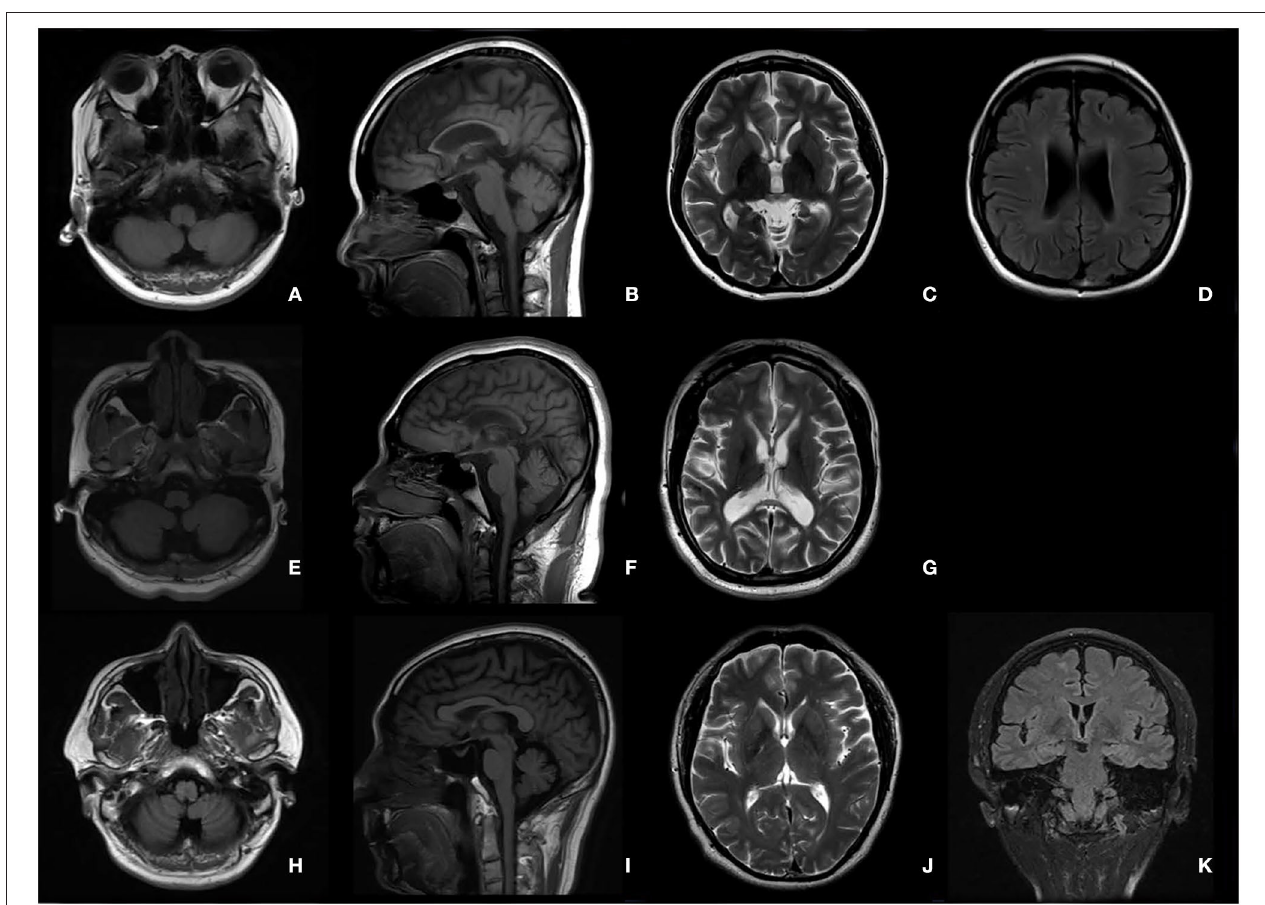
FIGURE 4 | Brain MRI in patients with SPG11 (A–D) , SPG15 (E–G) , and SPG 5A (H–K) . A thin corpus callosum (B,F) , “ear of the lynx” sign (C,G) , and ventricular dilation (D,G) were found in a female patient with SPG11 aged 25 years and a male patient with SPG15 aged 24 years. Periventricular white matter hyperintensities (D) are shown in the female patient with SPG11. No cerebellar atrophy was found in the patient with SPG11 (A) or in the patient with SPG15 (E) . Cerebellar atrophy was the major MRI in the male patient with SPG5A aged 21 years (H,I)